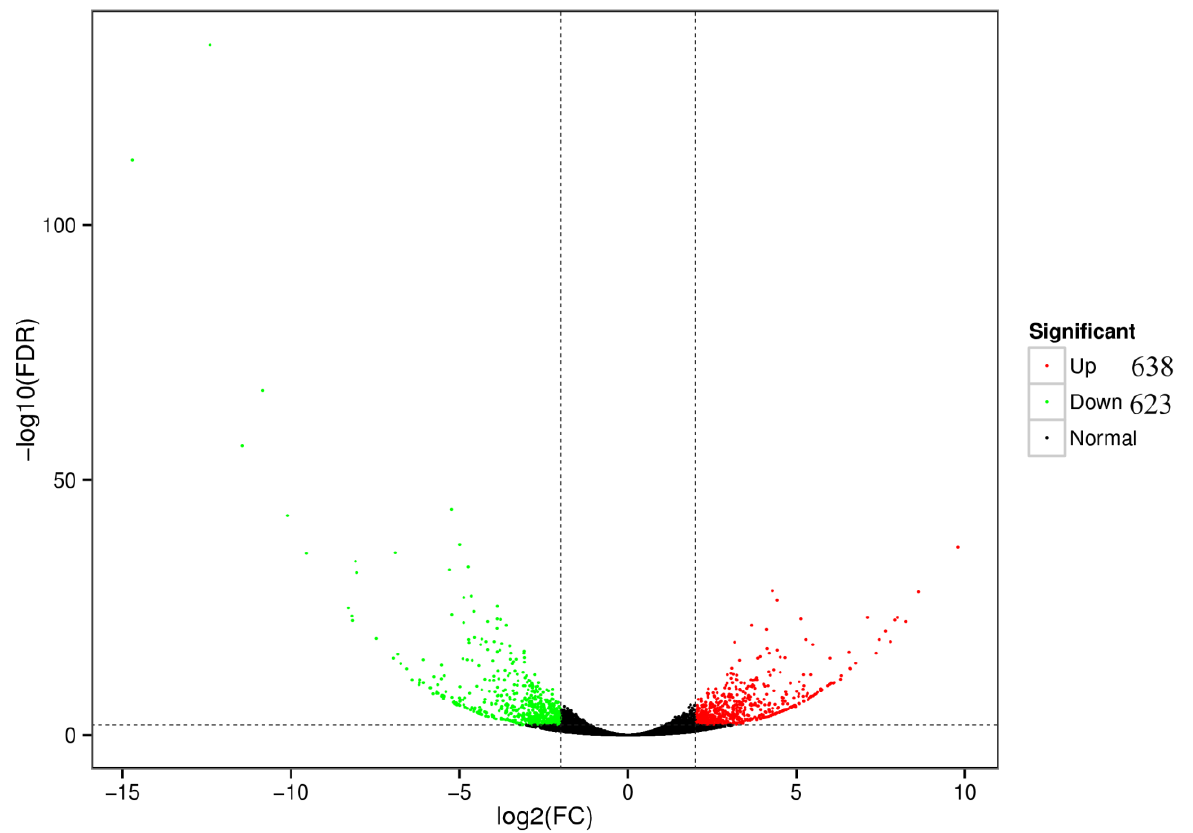
Figure 1. Volcano plot of distribution trends for differentially expressed genes between control groups and TCCA treatment groups. Each dot represents one gene. Red dots represent upregulated genes and green dots represent downregulated genes. Black dots represent genes with no differential expression.